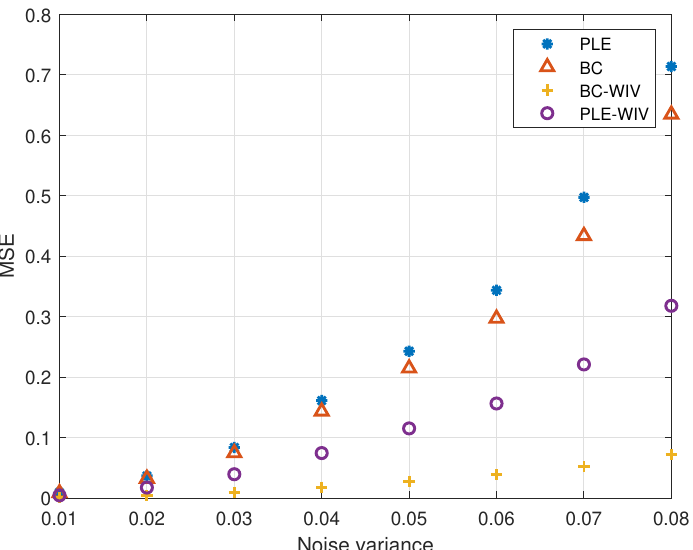
Figure 5. MSE with increasing noise standard deviation with a variance difference of 0.01 radian 2 for each method.